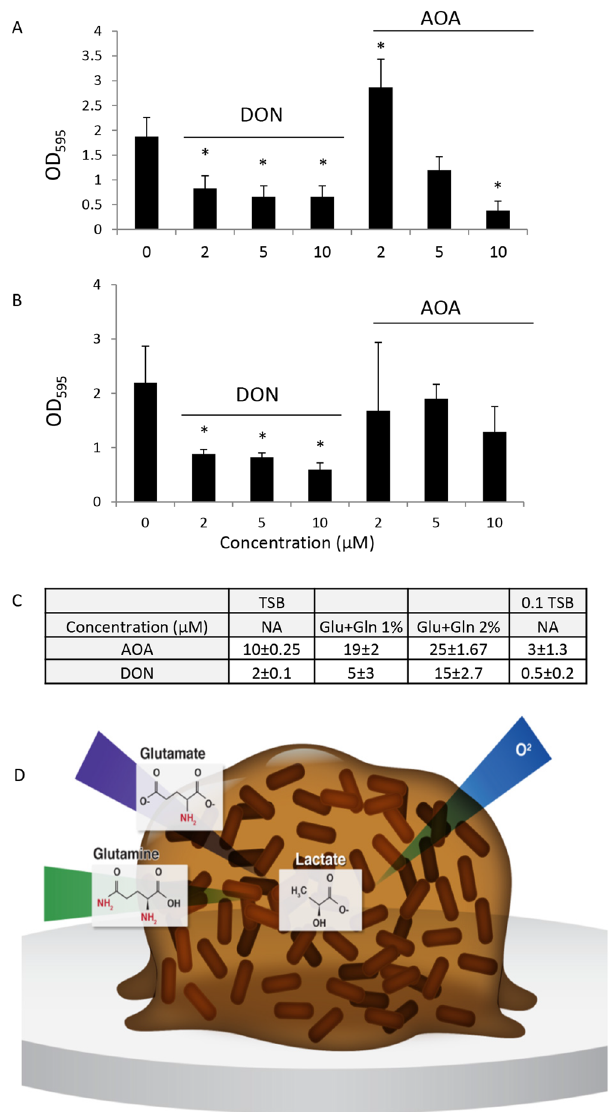
Figure 5. Glutamate and glutamine are essential for biofilm formation. ( A ) Biofilm quantification of E . faecalis biofilm formation, as judged by crystal violet staining. Biofilms were grown in different concentrations of the inhibitors in TSB-Glucose medium for 24 hrs. * P-value < 0.005 compared to the untreated control. ( B ) Biofilm quantification of P . aeruginosa biofilm formation, as judged by crystal violet staining. The results are the average for three independent experiments performed with ten technical repeats. Errors bars represent the corresponding standard deviations. Biofilms were grown in different concentrations of the inhibitors in TSB medium for 12 hrs. * P-value < 0.005 compared to the untreated control. ( C ) The change in the minimal biofilm inhibitory concentrations of DON and AHA in different growth media for E . faecalis biofilm formation. Results are average and standard deviation of one representative experiment out of three, performed with five technical repeats. ( D ) A schematic model representing the gradients of oxygen, glutamine/glutamate and lactate within biofilms, with the center being deficient of oxygen, glutamine and glutamate and enriched with